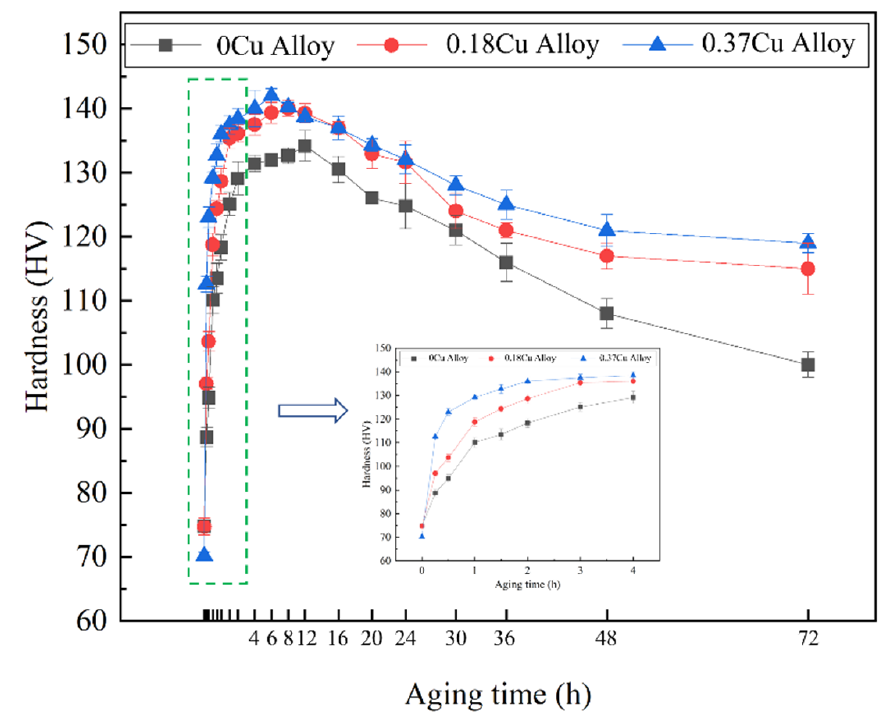
Figure 2. Artificial aging hardening curve at 175 ◦ C. Figure 2. Arti fi cial aging hardening curve at 175 °C.